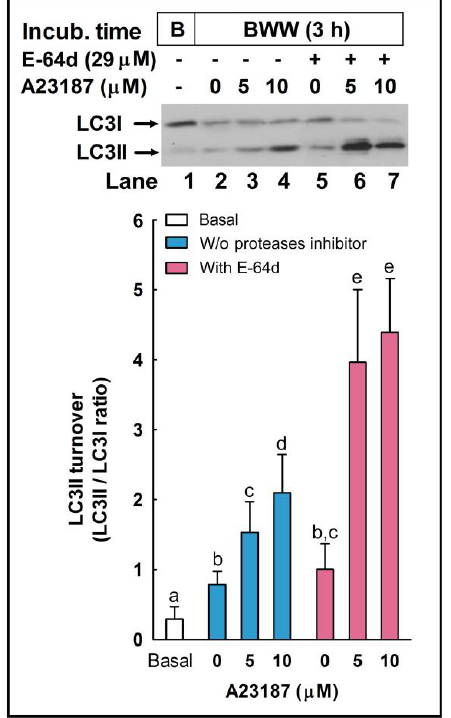
Figure 7. The effect of E64-d, a cathepsin inhibitor, on LC3II processing during the acrosome reaction in stallion spermatozoa. Equine spermatozoa were immediately processed (B; basal) or resuspended in BWW medium supplemented (lanes 2–4) or not (lanes 5–7) with the protease inhibitor E-64d (29 µ M) for 150 min and then were challenged with the indicated concentrations of A23187 (5 and 10 µM) or the vehicle (0 µM; DMSO) for 30 additional min (the final incubation time in all samples, except basal, was 180 min). After the incubation, samples were lysed, and LC3 turnover was assessed by western blotting with an anti-LC3 antibody that recognizes LC3I and LC3II. Results were expressed as the LC3II/LC3I ratio. Values represent the mean ± SEM of 5 independent experi- ments. Bars with different letters show statistical differences by a two- tailed Student’s t -test for un- paired samples ( p < 0.05).